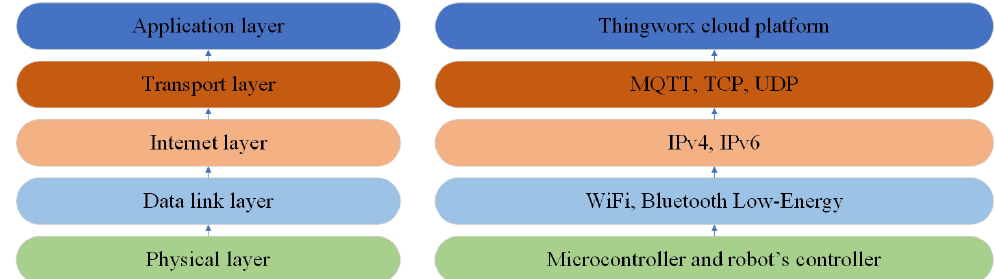
Figure 3. This figure shows the layout of the system in a simplified OSI diagram.